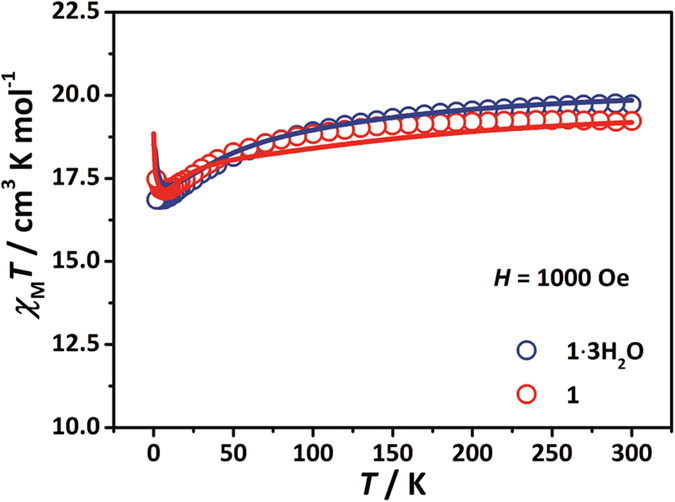
Temperature dependencies of χMT products for 1∙3H2O and 1.The temperature range is 1.8 K ≤ T ≤ 300 K, and the applied field of 1,000 Oe.